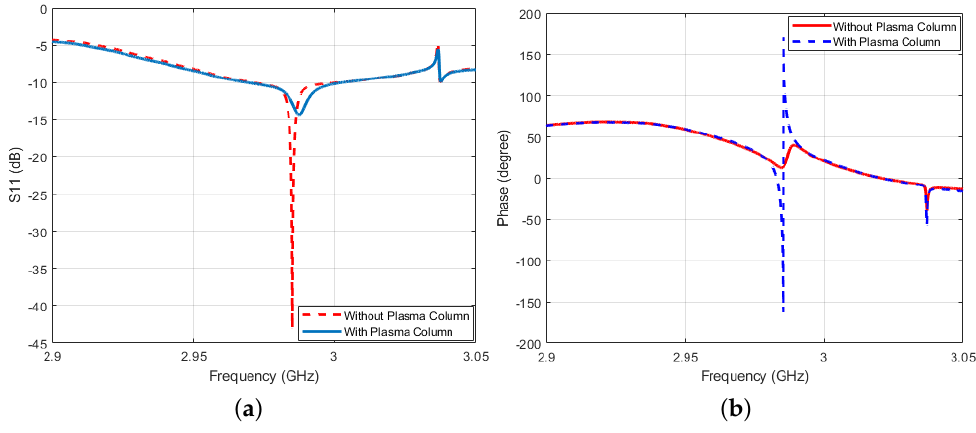
Figure 11. ( a ) Magnitude and ( b ) phase response of S 11